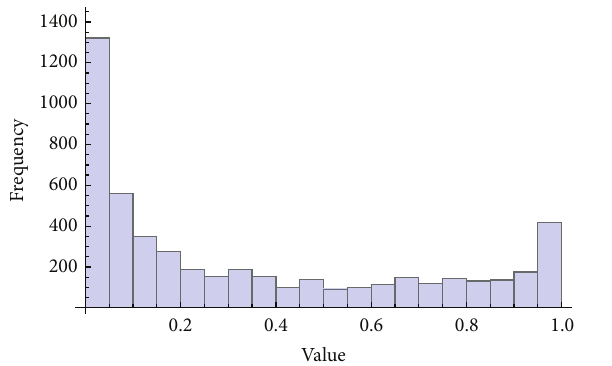
Figure 6: Histogram of the distribution of real numbers transferred into the range ⟨0 - 1⟩ generated by means of the chaotic delayed logistic map, 5000 samples.